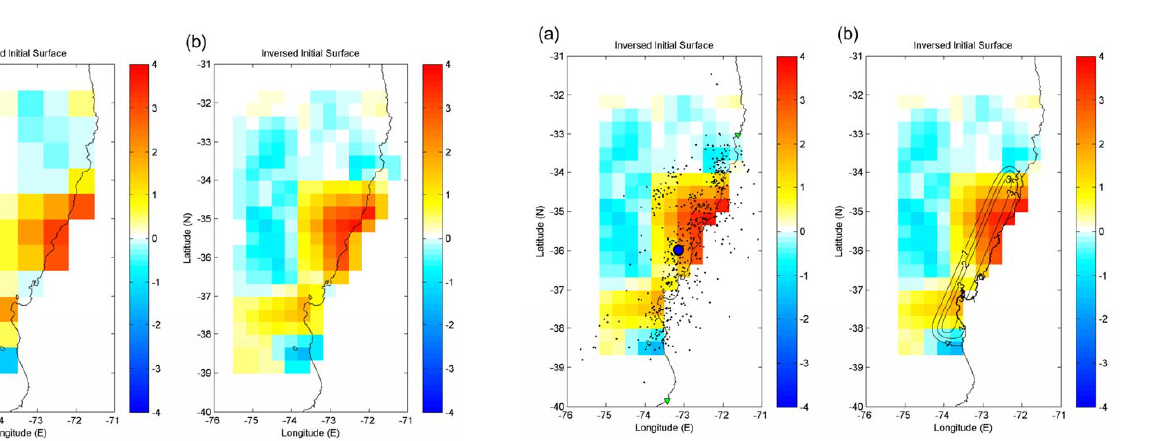
Fig. 8. Inversion result by SUTIM of 2010 Chile earthquake. (a) by Least square inversion and smoothing constraint. (b) with GSM. Color bar indicates the vertical displacement of the seafloor in meters.